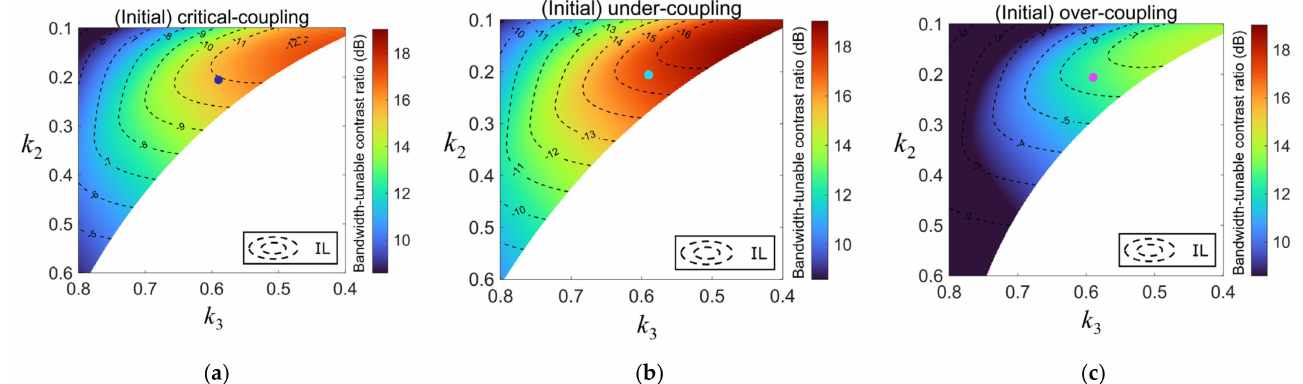
Figure 6. Bandwidth-tunable contrast ratio of the system under different initial coupling states. ( a – c ) indicate the evolution of the system bandwidth-tunable contrast ratios as a function of the coupling coefficient k 2 , k 3 , corresponding to the systems operating in the critical-coupling, under- coupling, and over-coupling conditions at initial detuning, respectively. The contour lines represent the distribution of system insertion loss (IL).